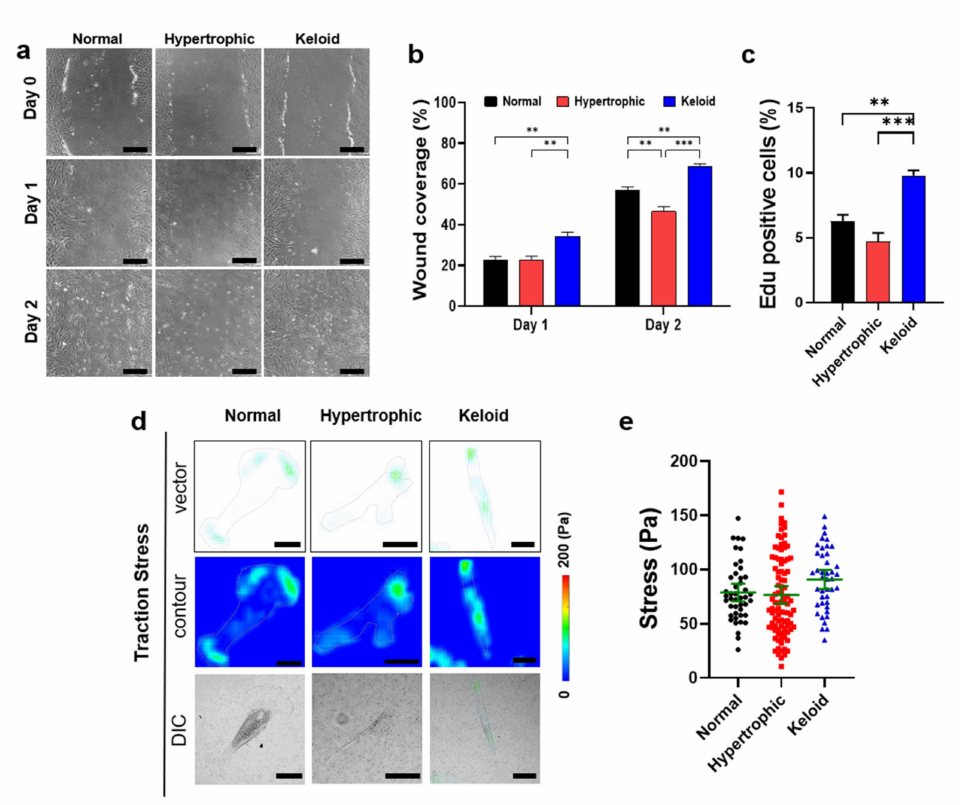
Figure 4. Characterization of the cell motility of dermal fibroblasts from NHK patient-derived scar tissues. ( a , b ) Wound- scratch assay for NHK dermal fibroblasts. Scale bar = 500 µ m. Data represent the mean ± SEM. ** p < 0.01; *** p < 0.001. ( c ) Flow cytometry analysis of 5-ethynyl-2 (cid:48) -deoxyuridine (EdU)-positive cells. Data represent the mean ± SEM. ** p < 0.01; *** p < 0.001. ( d , e ) Traction stress data in normal ( n = 44), hypertrophic ( n = 96), and keloid dermal fibroblasts ( n = 42). Scale bar = 50 µ m. Data represent the mean (green line) ± 95% confidence interval (green error